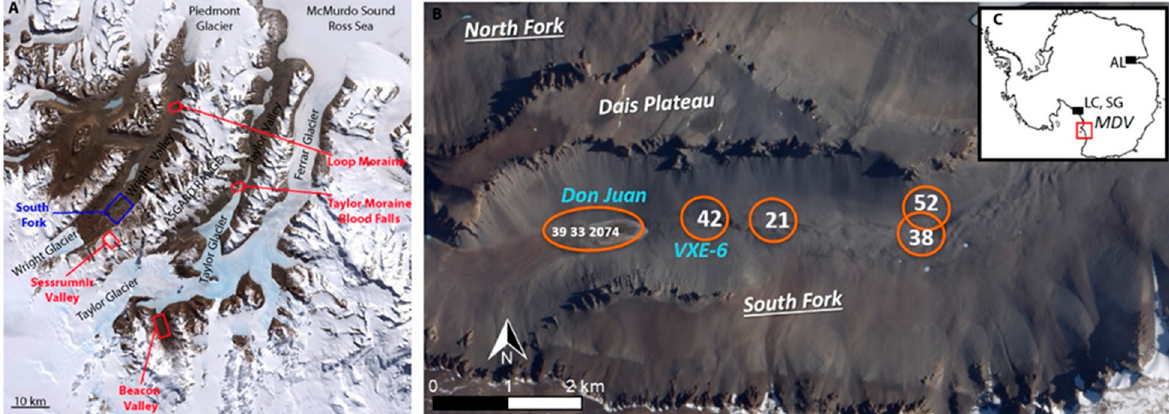
Figure 1. Location maps of sampling sites in Antarctica. ( A ) Location of the South Fork catchment (blue) in the McMurdo Dry Valleys compared to other sampling sites for the sediments (red) studied by Bao and Marchant [7]. Image credit: Landsat 7. ( B ) Locations of seven sampling sites in the South Fork catchment analyzed in our study. Image credit: Google Earth. ( C ) Regional map of Antarctica showing approximate locations of the McMurdo Dry Valleys (MDV), Lewis Cliff (LC), Shackleton Glacier (SG), and Ace Lake (AL).